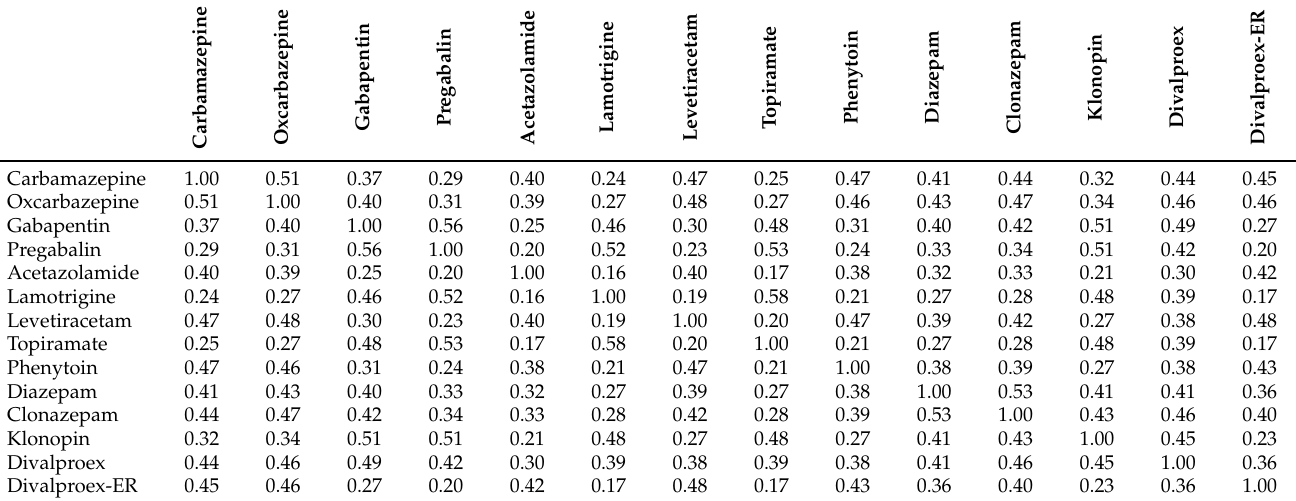
Table 5. AEDs Drug-Drug Similarity using JC